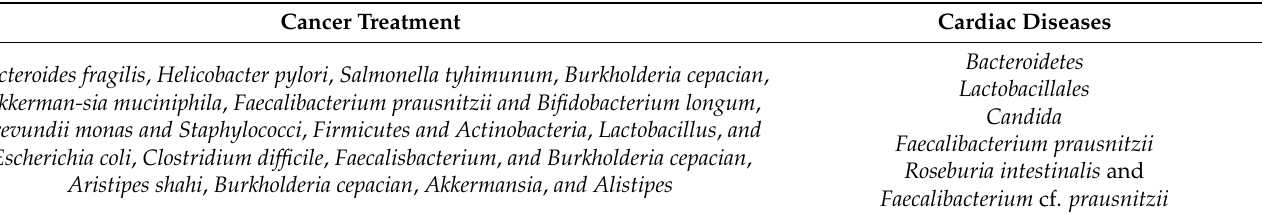
Table 1. Some of the gut bacteria associated with cardiac diseases and cancer treatment. Cancer